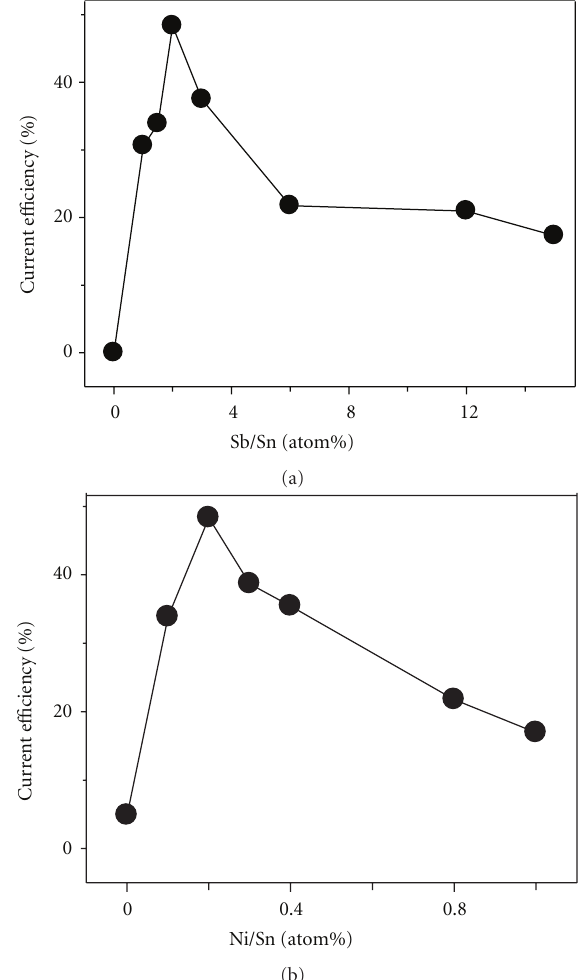
Figure 6: The e ff ect of (a) Sb concentration in Ti/SnO 2 -Sb( x %)- Ni(0.2%) and (b) Ni concentration in Ti/SnO 2 -Sb(2%)-Ni( x %) electrodes on the current e ffi ciency for EOP in 0.1 M H 2 SO 4 at room temperature at an applied current density of 12 mAcm − 2 . The values in parentheses are atomic ratios with respect to